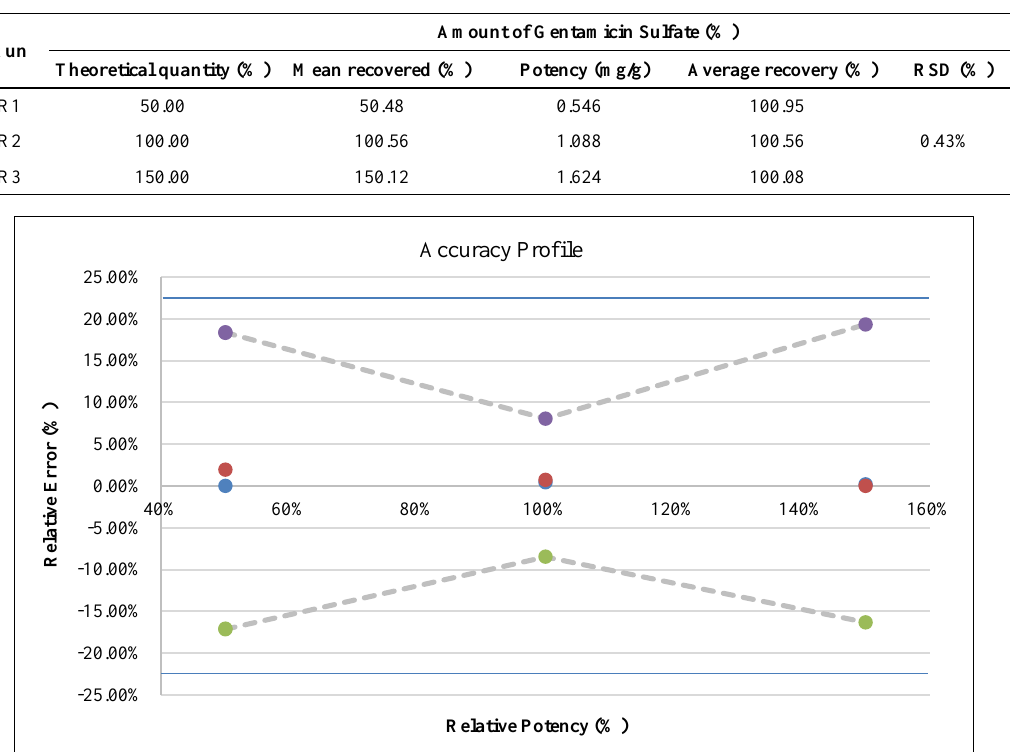
Figure 3. Accuracy profile obtained for method of microbiological dosage of Gentamicin Sulfate using 2×2 design in large antibiotic plates. Solid lines represent acceptance limits (-22.5%, 22.5%) around the target value, dashed lines represent 95% tolerance interval reached. When tolerance intervals are confined within specification limits, the assay can be quantified with reasonable